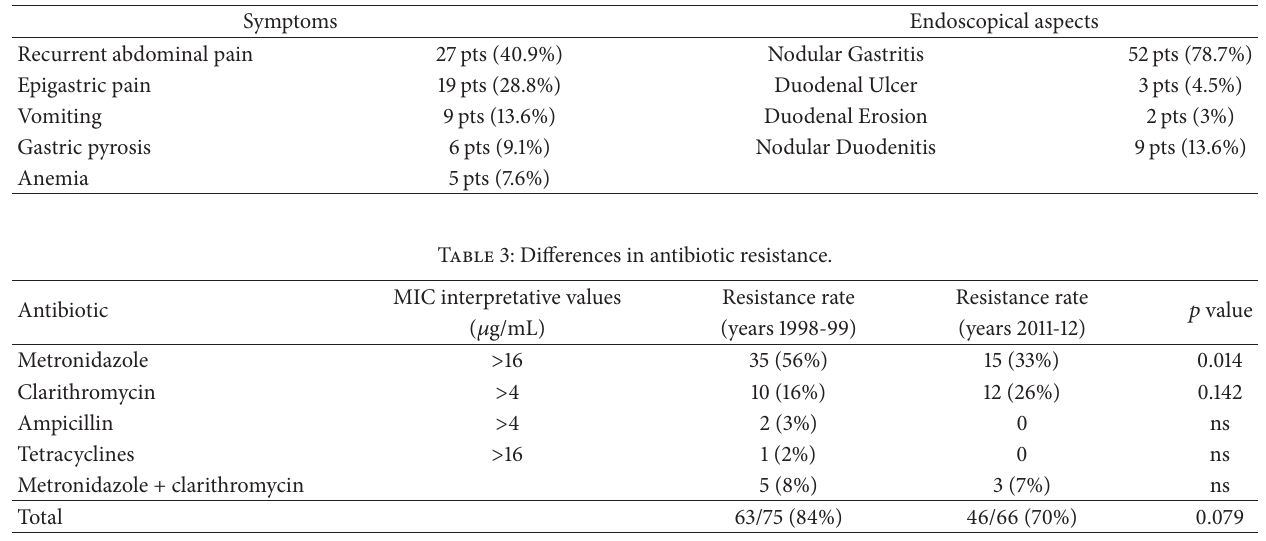
Table 2: Clinical and endoscopical characteristics of patients.